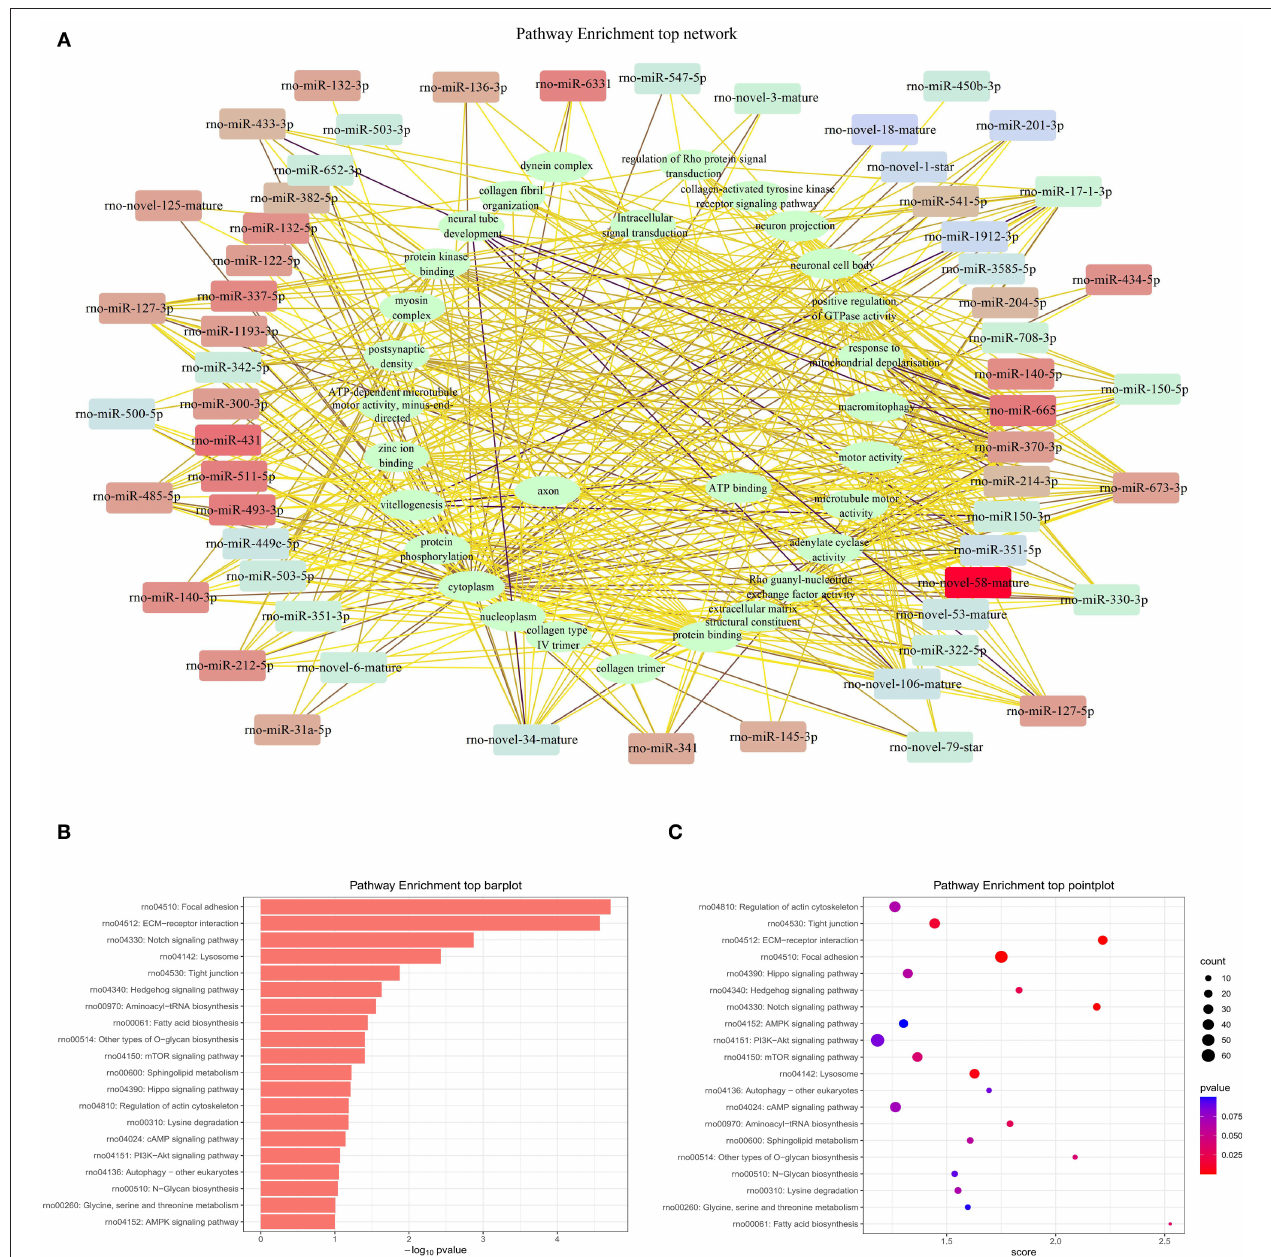
FIGURE 10 | The top pathway enrichment analysis. (A) Network of top pathway enrichment. (B) Barplot of top pathway enrichment. (C) Pointplot of top pathway